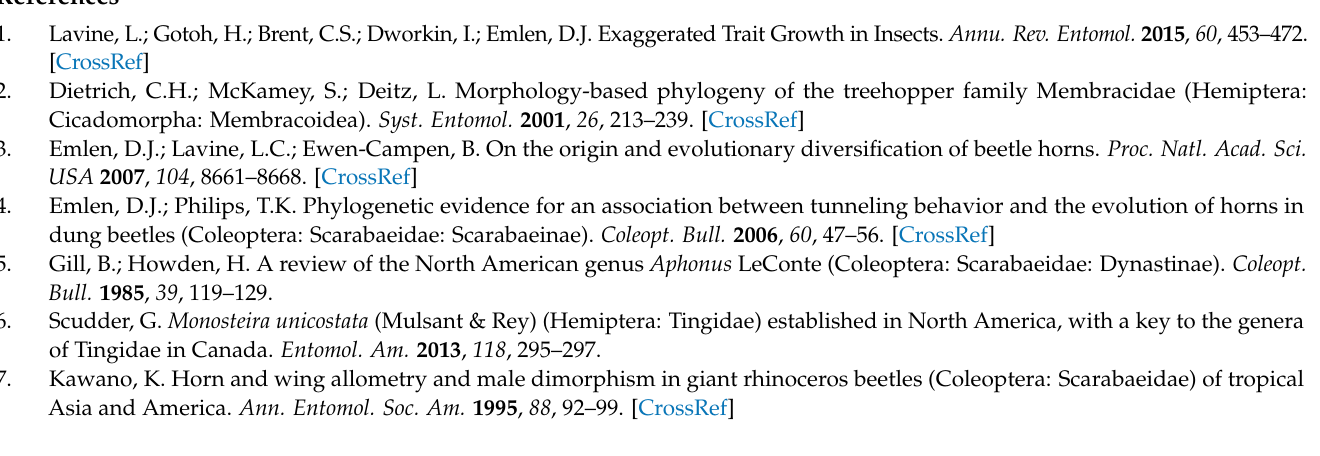
Figure S1: Strict consensus tree of 2 MP trees from equally weighted parsimony analysis using TNT; Table S1: Raw data of morphometric analyses of two indexes of hind legs; Figure S2: The size comparisons between Antiqusolidus maculatus and associated plants in Mesozoic; Table S2: A list of rutelines with marking patterns and feeding types; Figure S3: Markings and color patterns of extant Rutelinae ( Anomala trivirgata Fairmaire, 1888) feeding on